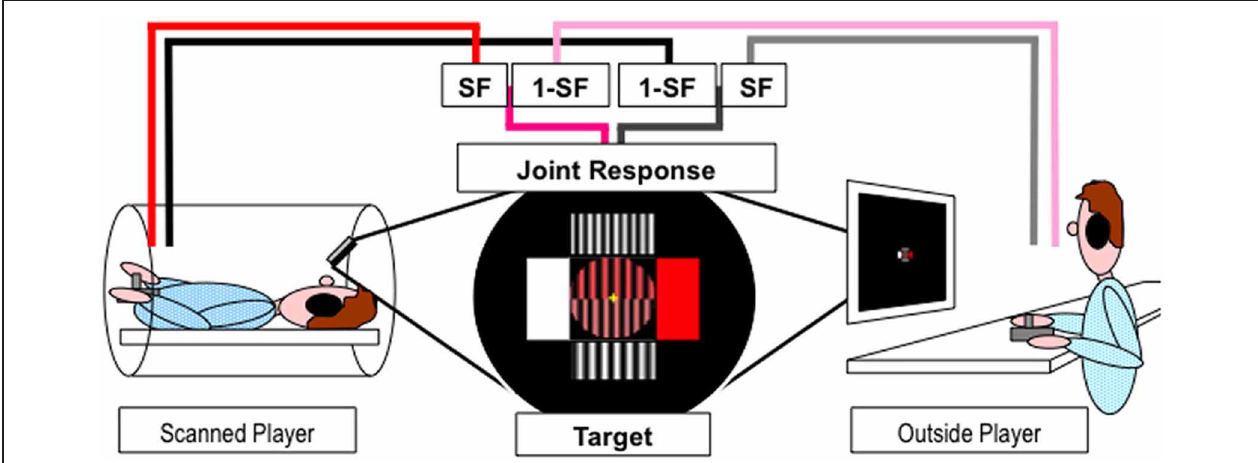
FIGURE 1 | Experimental paradigm. Players inside and outside the scanner used joystick jointly control a dynamic object (stripes of varying width and shades of pink) presented in the upper half of the circle at the center of the